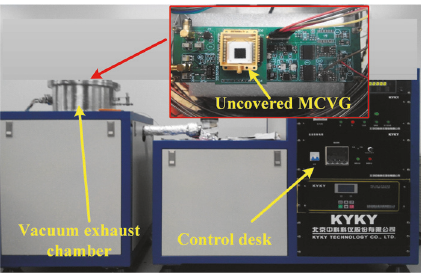
Figure 15: Test system of Q